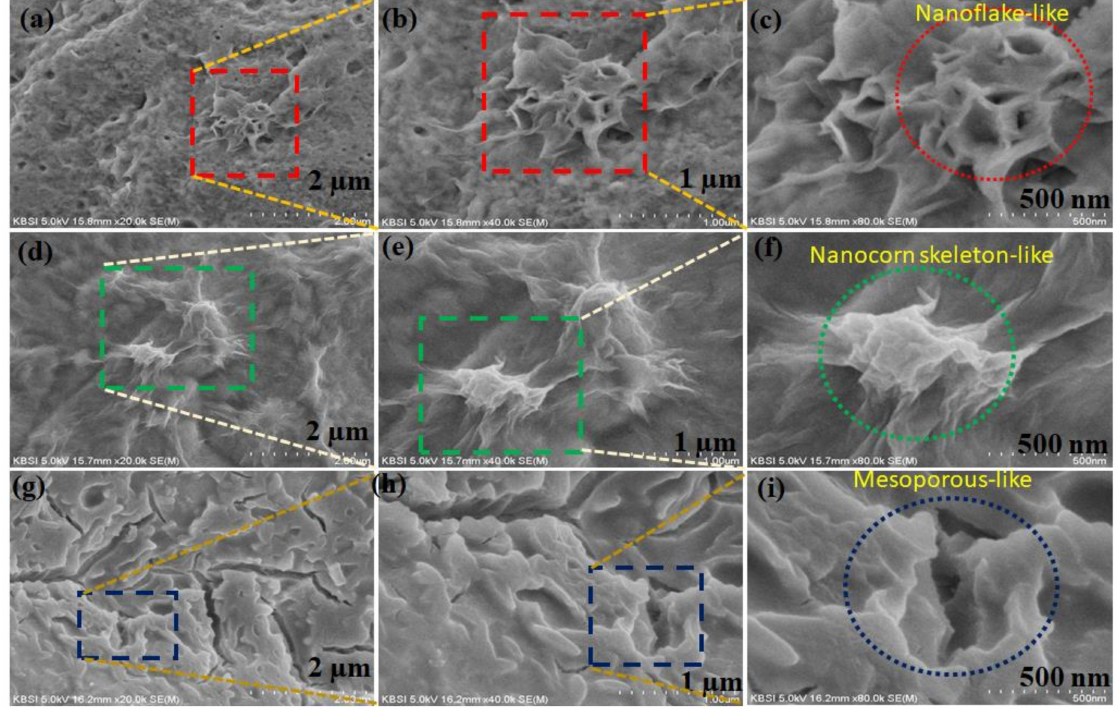
Figure 3. ( a – c ) SEM and FE-SEM images of CZ1h, ( d – f ) SEM and FE-SEM images of CZ3h and SEM and ( g – i ) FE-SEM images of CZ7h